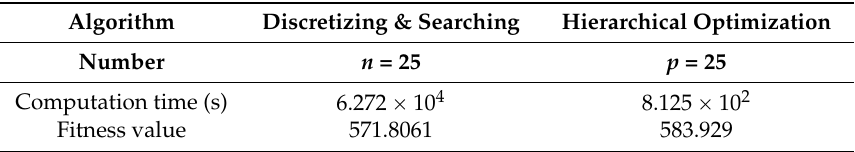
Table 3. Numerical efficiency analysis for different